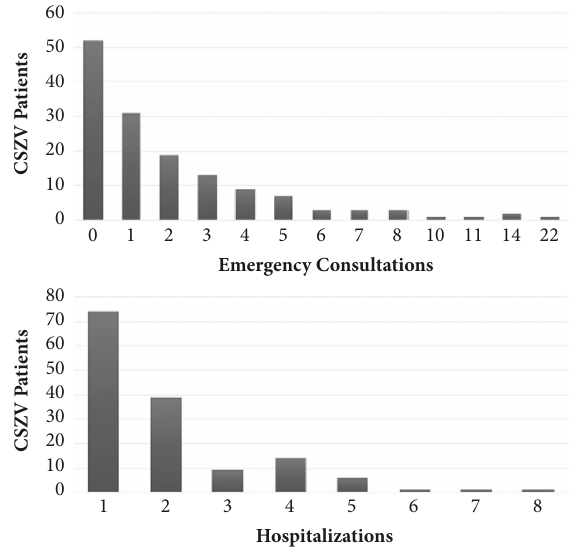
Figure 1: Number of emergency visits and admissions of patients with CZVS up to 25 months of life. IMIP, August 2015 to October